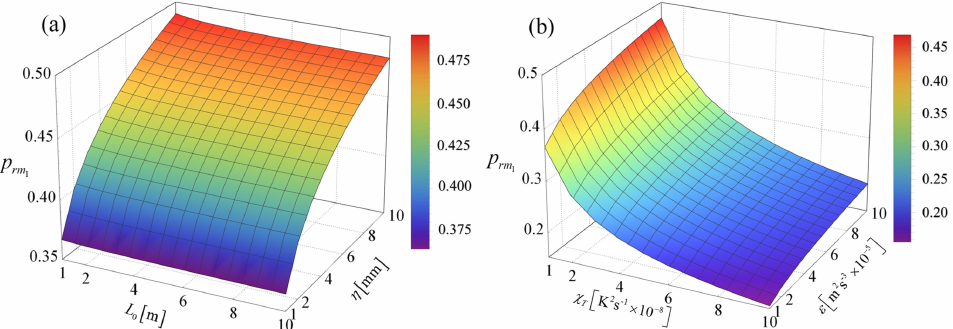
Figure 7. Relative detection probability of signal photon under ( a ) different outer scale turbulences L 0 and inner-scale turbulences η ; ( b ) different dissipation rates of mean-squared temperature χ T and different dissipation rates of kinetic energy per unit mass of fluid (cid:101) ( z = 50